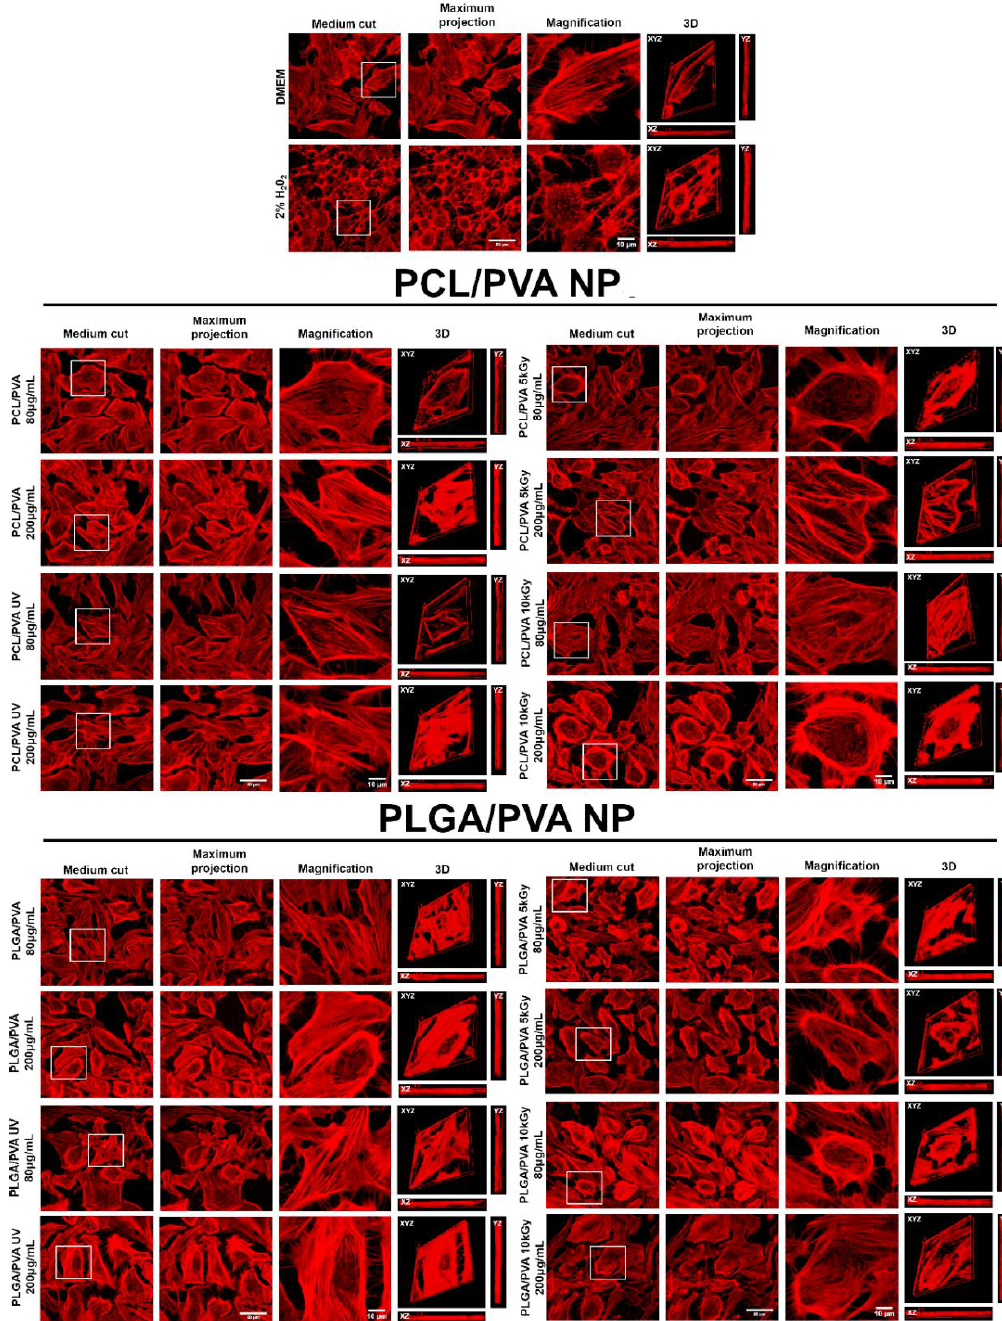
Figure 6. Phalloidin immunolocation in MIO-M1 cells exposed to 80 and 200 µ g / mL of PCL / PVA and PLGA / PVA NP for 48 h. Upper: untreated cells with maintenance medium and control of cellular stress with treatment of 2% H 2 O 2 are shown. Middle: MIO-M1 cells were treated with non-irradiated or irradiated PCL / PVA NP with UV light or gamma irradiation (5 or 10 kGys). Lower: MIO-M1 cells were treated with non-irradiated or irradiated PGLA / PVA NP with UV light or gamma irradiation (5 or 10 kGys). Scale bar = 10 µ m. We performed microscopy visualization by medium cut, maximum projection magnification and 3D